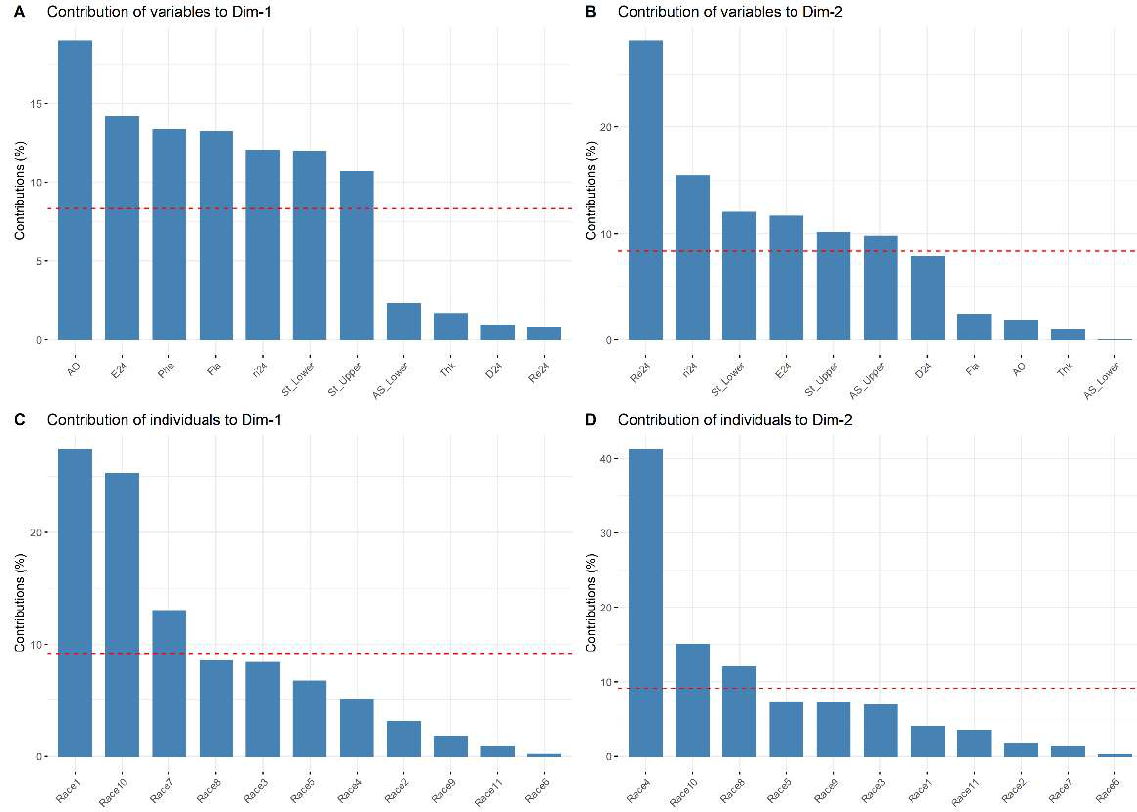
Figure 1. Contribution of the variables ( A , B ) and maize races ( C , D ) at 24 h. The dotted red line indicates the expected average contribution of the variable and maize race. Variables or maize races with a contribution larger than this cutoff is considered important in contributing to